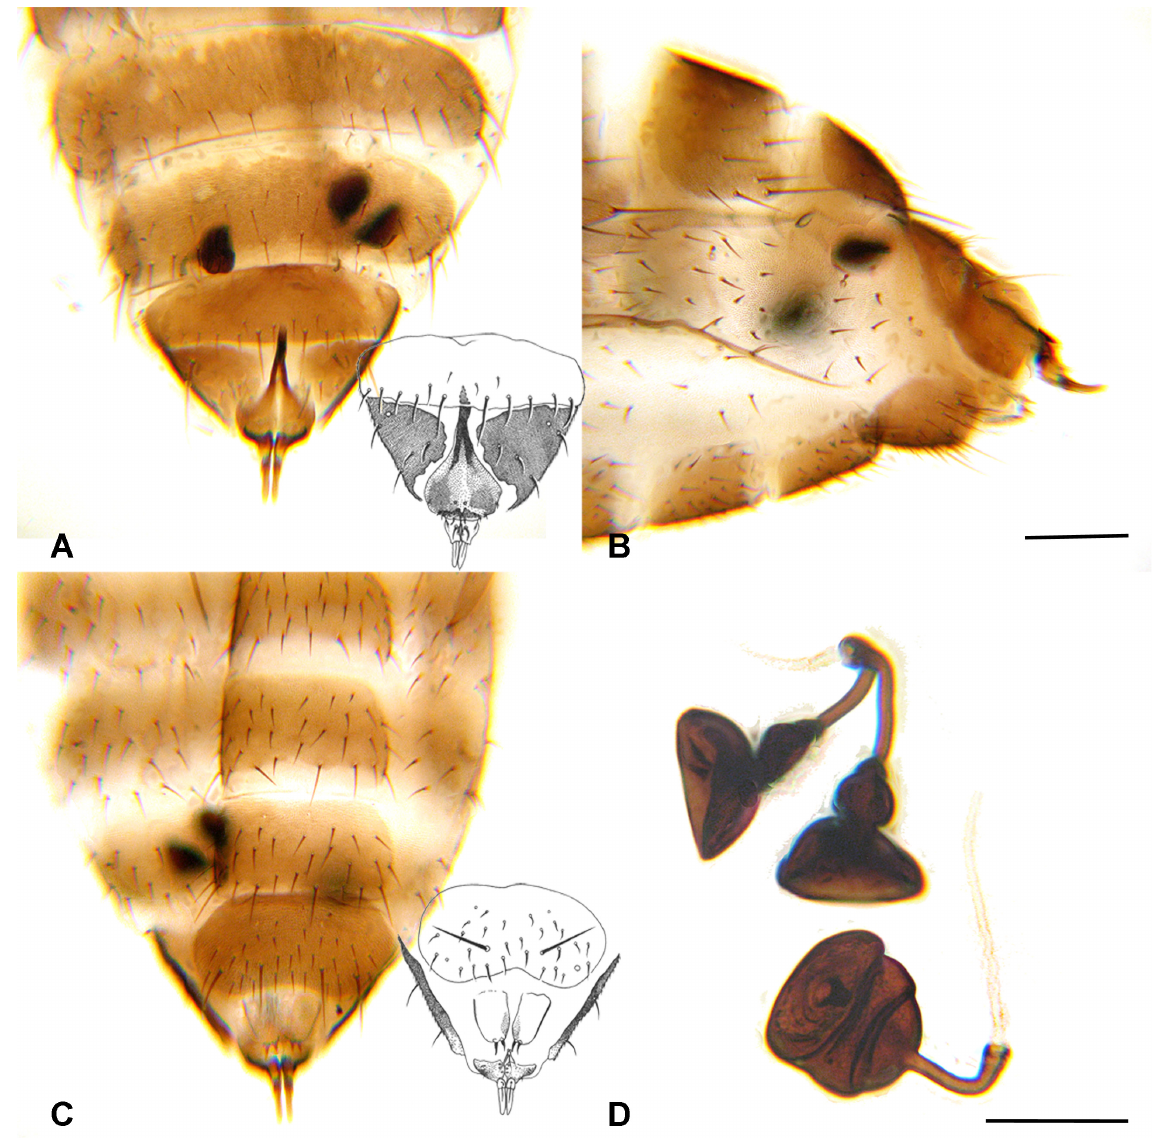
Fig. 10. Rudolfina exuberata sp. nov., female terminalia (A–C: debu00242299; D: debu00242286). A . Terminal abdominal segments, dorsal view. B . Same as preceding, lateral view. C . Same as preceding, ventral view. D . Spermathecae. Scale bars: A–C = 0.10 mm; D = 0.03